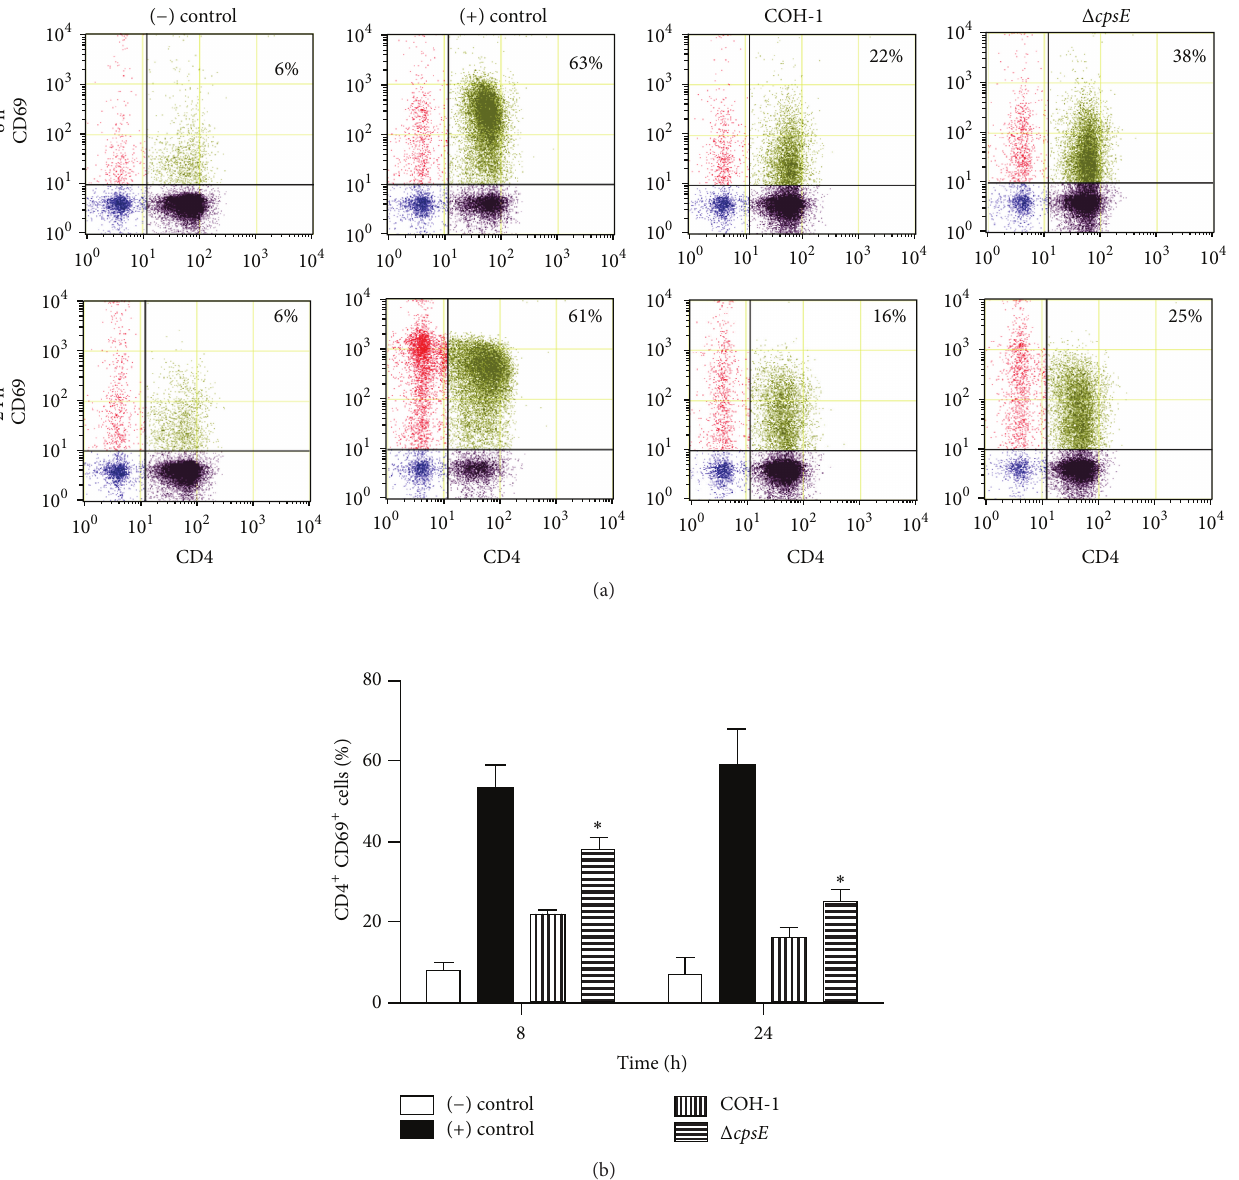
Figure 8: Role of bacterial capsular polysaccharide in the modulation of CD4 + T cell surface expression of CD69. Dendritic cells (DCs) were infected with either wild-type GBS strain COH-1 or its nonencapsulated isogenic mutant Δ cpsE (MOI:1) for 1h. Extracellular bacteria were killed by antibiotic treatment and cultures washed prior to addition of freshly isolated splenic CD4 + T cells from na¨ıve mice (T cell : DC ratio of 5 : 1). Cocultures were incubated for 8 h and 24 h, cells were harvested, and CD69 expression was analyzed by FACS. Cocultures incubated with medium alone or Concanavalin (0.1 𝜇 g/mL) served as negative ( − ) and positive controls (+), respectively. (a) Representative data from 3 different experiments. Twenty thousand gated events were acquired per sample and data analysis was performed using Cell Lab Quanta Collection/Analysis software. Quadrants were drawn based on FITC- and PE-control stains and were plotted on logarithmic scales. Numbers in the upper quadrants indicate the % of CD4 + CD69 + cells. (b) Data are expressed as means ± SEM from 3 different experimental infections; ∗ 𝑃 < 0.05 indicates statistically significant differences between cocultures infected with wild-type strain COH-1 and those infected with the nonencapsulated mutant Δ cpsE